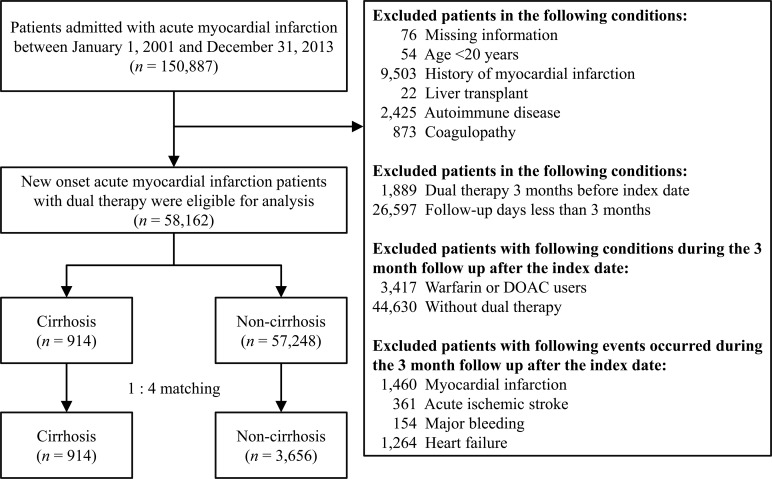
Flow chart for the inclusion the study patients.